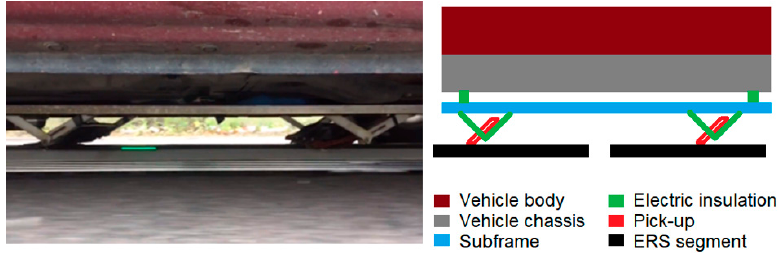
Figure 8. Real pick-up installation on a test vehicle ( left ) and concept drawing identifying the main components ( right